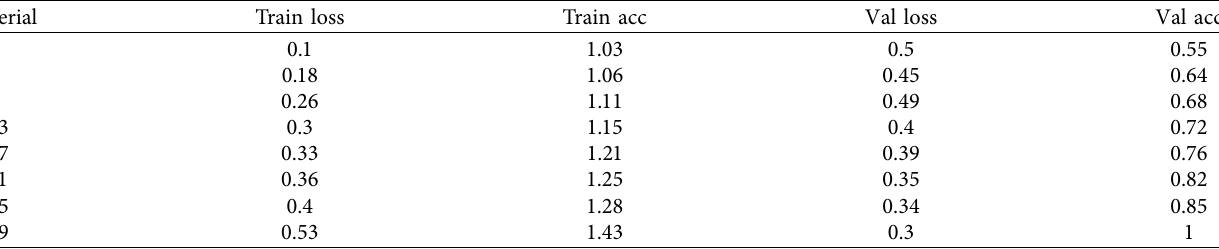
Table 7: Training results of diferent network models.